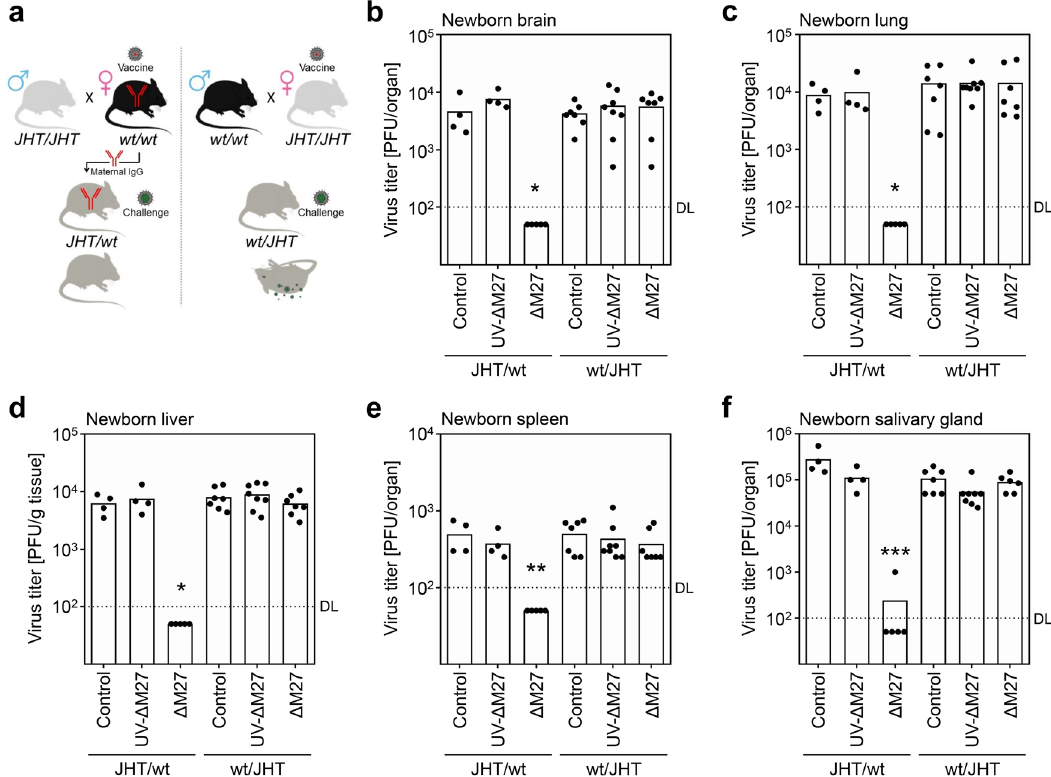
Fig. 9 Maternal antibodies are indispensable for mother-to-child transmitted protection. Female C57BL/6 and C57BL/6 JHT/JHT (JHT) mice were vaccinated with UV-irradiated Δ M27-MCMV ( Δ M27-UV), Δ M27-MCMV ( Δ M27) or mock vaccinated (control). At 2 weeks post vaccination, C57BL/6 female mice were mated with C57BL/6 JHT/JHT males and C57BL/6 JHT/JHT female mice with C57BL/6 males. To analyze the protection of the offspring, at ~24 h postpartum, newborns were challenged i. p. with 500 PFU of MCMV:eGFP per mouse. At 9 d post challenge, the indicated organs were harvested and virus titers were determined by plaque titration. wt and JHT indicate the genotype of dams. a Schema of the experimental design. b Virus titers of brains of pups. c Virus titers of lungs of pups. d Virus titers of livers of pups. e Virus titers of spleens of pups. f Virus titers of the salivary gland of pups. Bars depict the geometric mean, dots show titers of individual mice ( n = 4 – 8 per group). DL detection limit. All vaccinated groups were compared to the corresponding control group by Kruskal – Wallis test corrected for multiple comparisons by controlling the false discovery rate. * p value <0.05. ** p value <0.01. *** p value